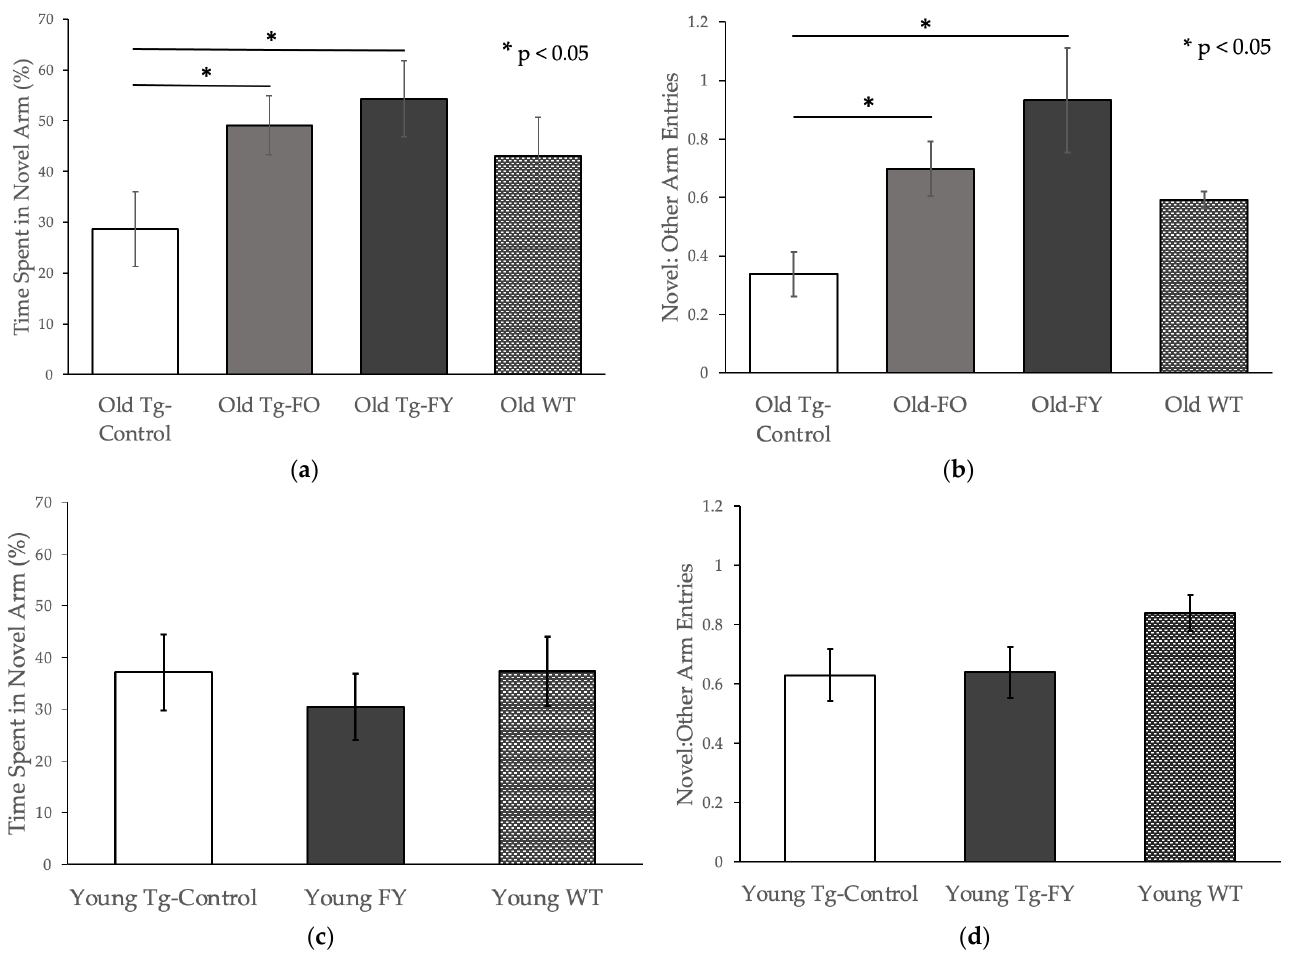
Figure 4. Spatial memory levels improved in Old treated mice in Forced Alternation Y-maze. Data is presented as mean ± SEM. Old Tg-FO ( n = 8) and Old Tg-FY ( n = 8) demonstrated increased ( a ) exploration time in Novel arm and ( b ) Ratio of Novel to Open arm entries ( p < 0.05 compared to Old Tg-Control ( n = 7)). ( c , d ) Young Tg-FY ( n = 8) did not show improvement in FAY compared to Young Tg-Control ( n = 7). WT values are presented for comparison only. Young Tg-FY: Young